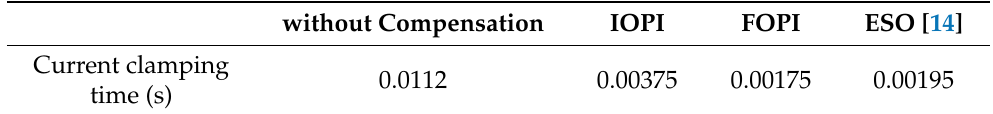
Figure 29. Comparison of Ia current response under 40 r/min speed conditions. Table 11. The performance index comparison of I a current step current response under 40 r/min speed conditions.